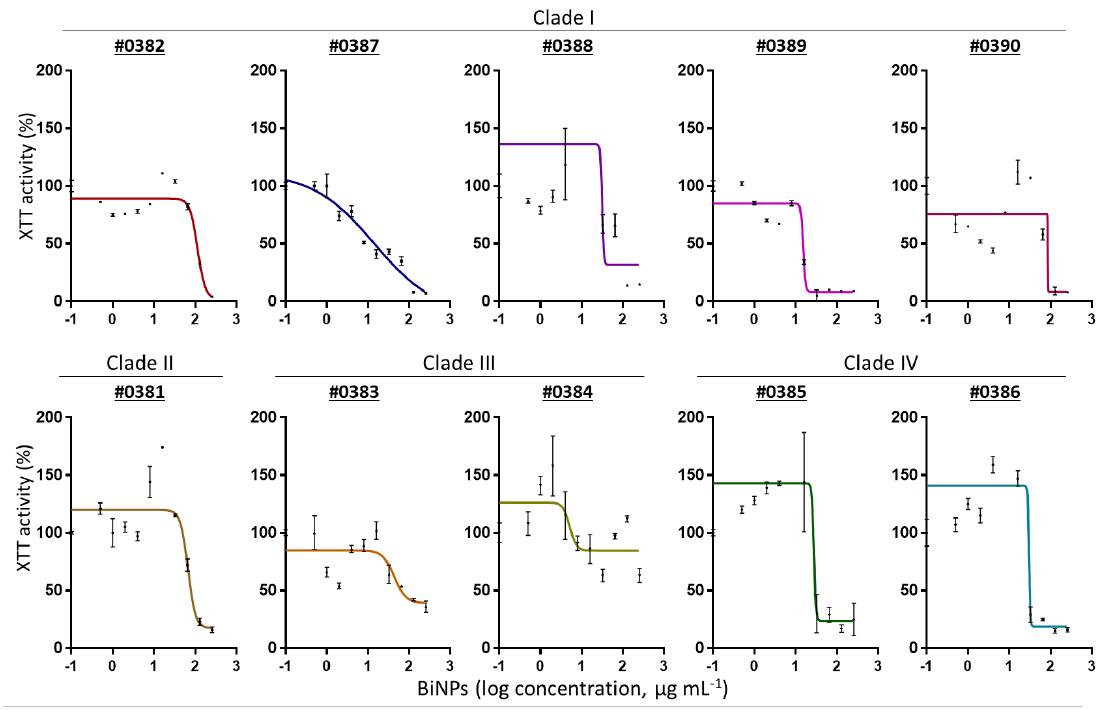
Figure A1. Susceptibility of the multiple C. auris strains, clustered by clade, exposed to BiNPs during the biofilm formation stage. The dose–response curves (continuous line) show the effect of the BiNPs (as XTT absorbance readings) during biofilm formation in the multiple strains of C. auris , clustered by clade. Within each graph, the individual points show the average absorbance % over the BiNPs concentration, whereas de vertical bars in each point represent the standard deviation ( n = 6).